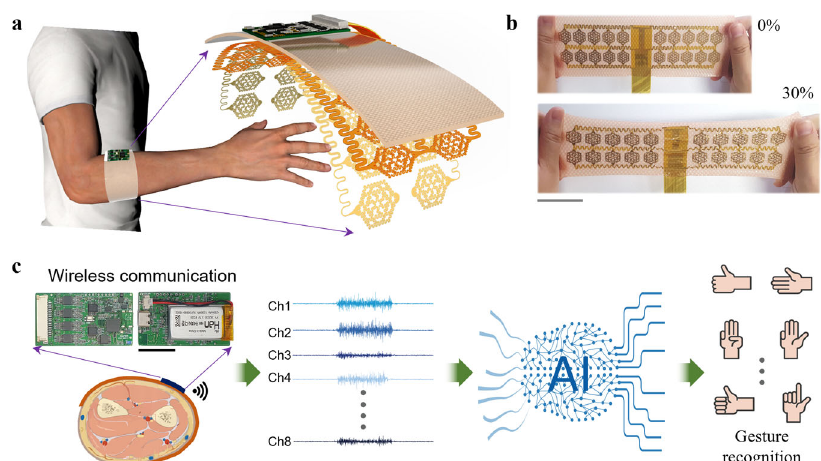
Fig. 1 Concept image of the stretchable array sEMG sensor with GNN for static and dynamic gestures recognition system. a Schematic illustrating the human arm wearing the wireless acquisition device integrated with the stretchable array EMG sensor for real-time monitoring of EMG signals. b The wearable array sensor at pristine (0%) and stretched (100%) conditions (scale bar 4 cm). Process fl ow of gesture recognition starting from the recording of sEMG signals to gesture recognition with an AI-based graph attention network: c Cross-section view of the posterior forearm showing various muscles and the sensor covering a large portion of the muscles at the outermost layer of skin, along with the real image of PCB (front and back, scale bar 2 cm). The sEMG signals are supplied to the AI programming for gesture recognition